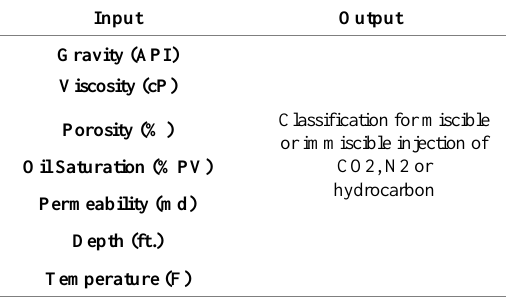
Table 2. Input and output parameters for training artificial neural network(s) in development of screening tool